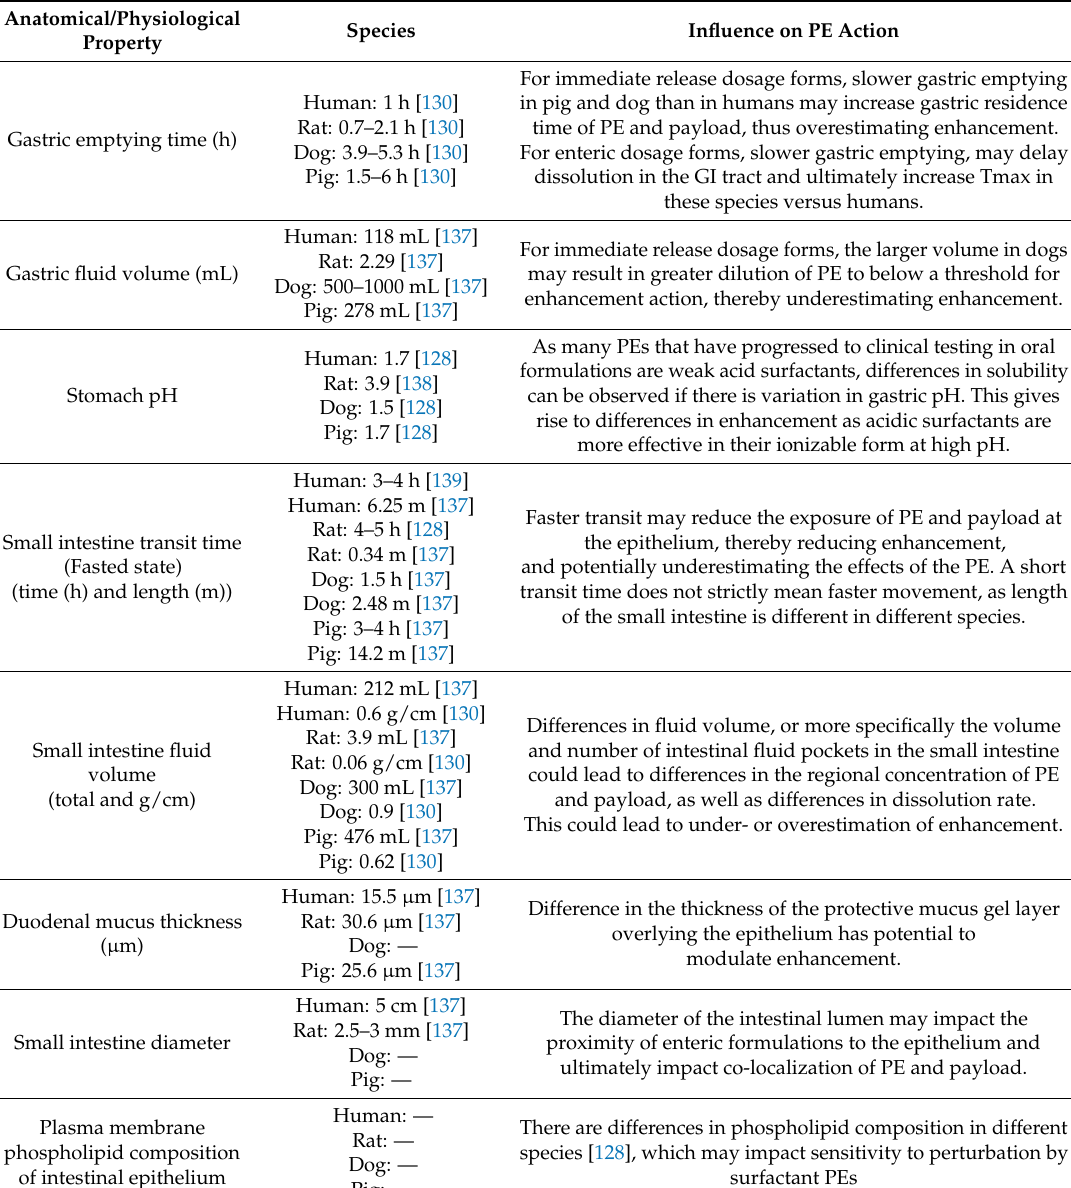
Table 3. Potential effects of GI physiology in different animals on the action of